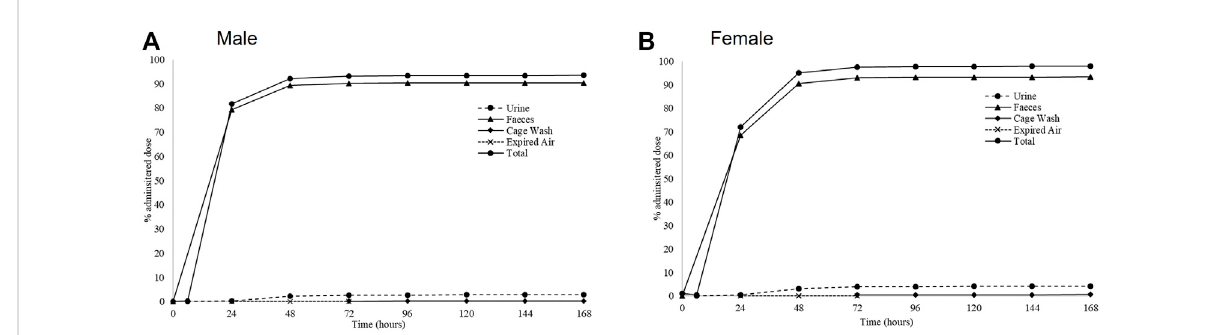
FIGURE 4 Excretion routes of zapnometinib. Mean cumulative excretion of radioactivity during 168 h following a single oral administration of [ 14 C]- zapnometinib (30 mg/kg) to male (A) and female (B) rats (Group 2). Mean values of n = 3 animals are shown. Individual values and SD see Supplementary Tables S2,